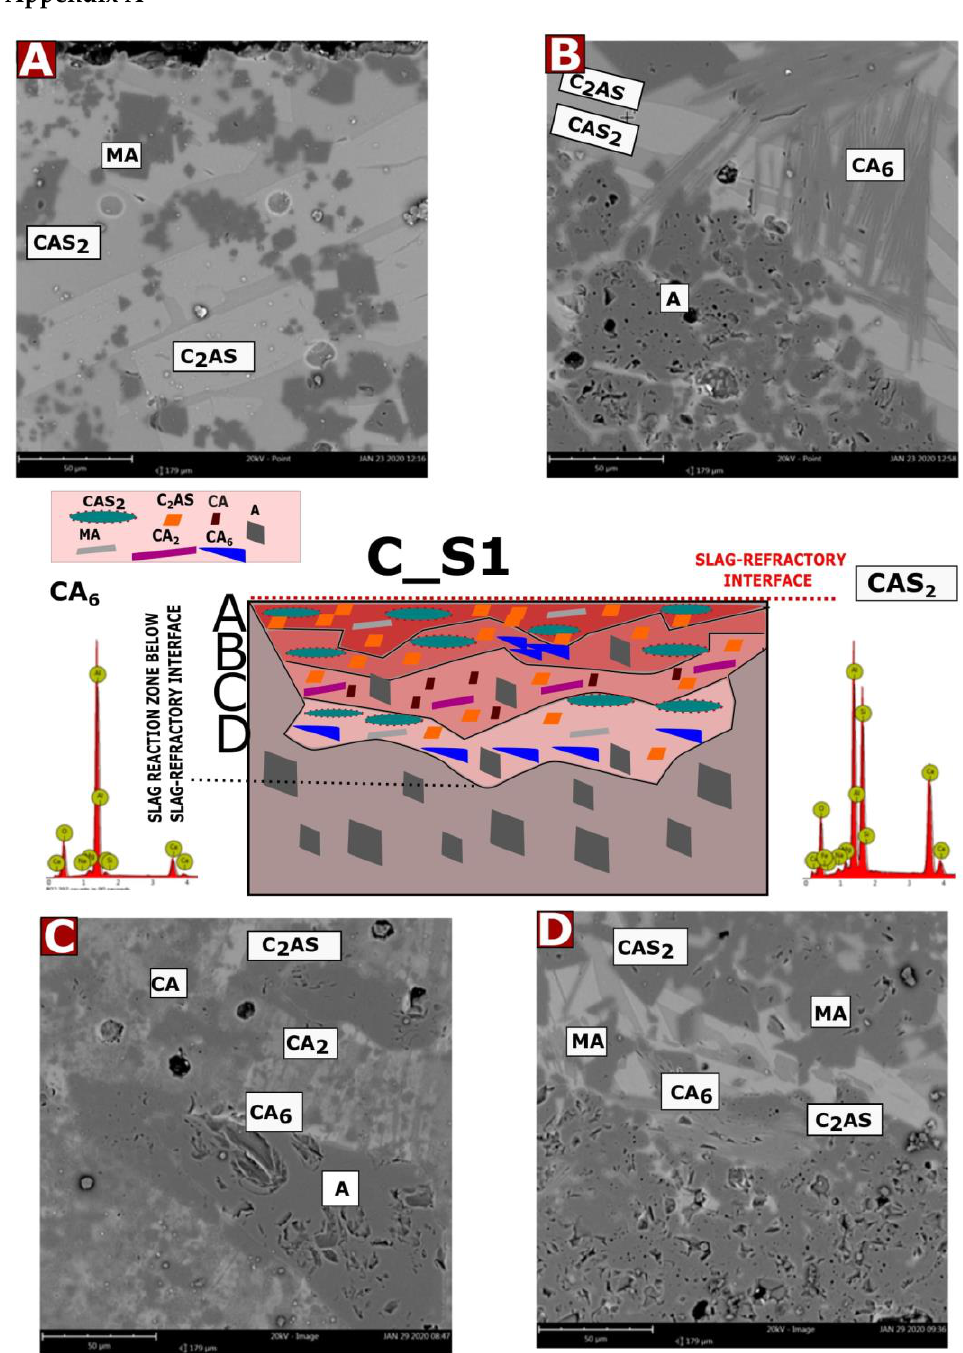
Figure A1. ( A – D ) In the center is a schematic diagram of the phases present in the castables-slag S1 sample after corrosion. In the corners, there are photos of SEM micro-areas, as well as selected EDS.